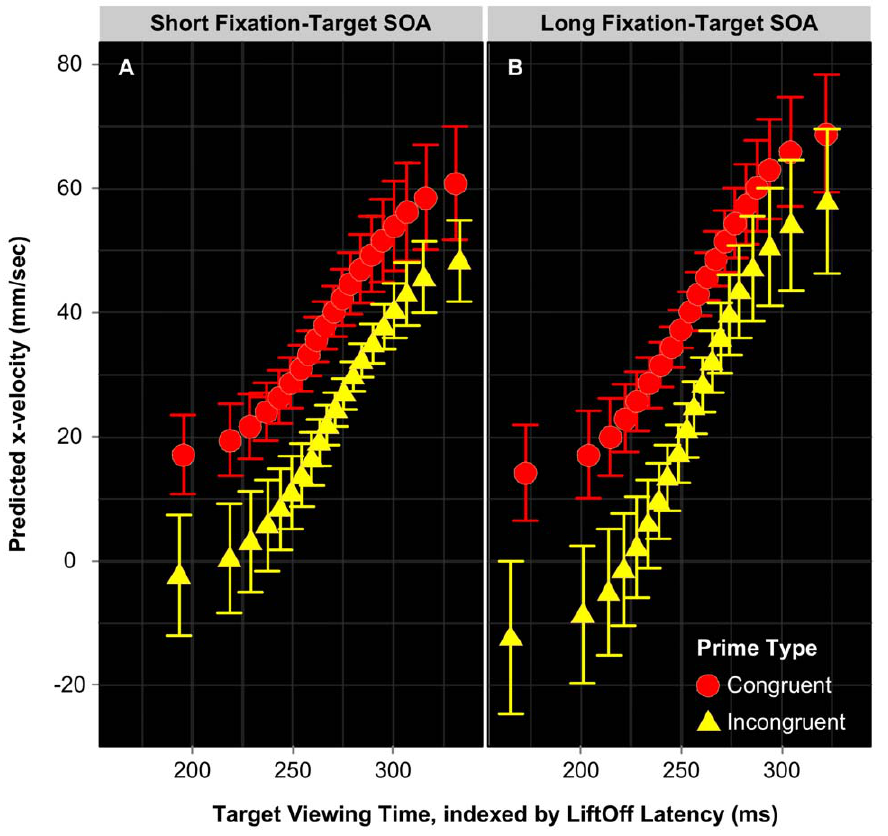
Figure 6. Predicted x-velocity as a function of Target-Viewing Time for short (A) and long SOA (B). All values correspond to an average of the initial 20% of the reaching response. Target-Viewing Time (always preceded by 50 ms of prime processing) positively modulated participants’ classification certainty, such that the longer they waited to begin their reaching response, the faster their finger moved in the correct direction during the early stages of their movement. Error bars calculated using within-subjects